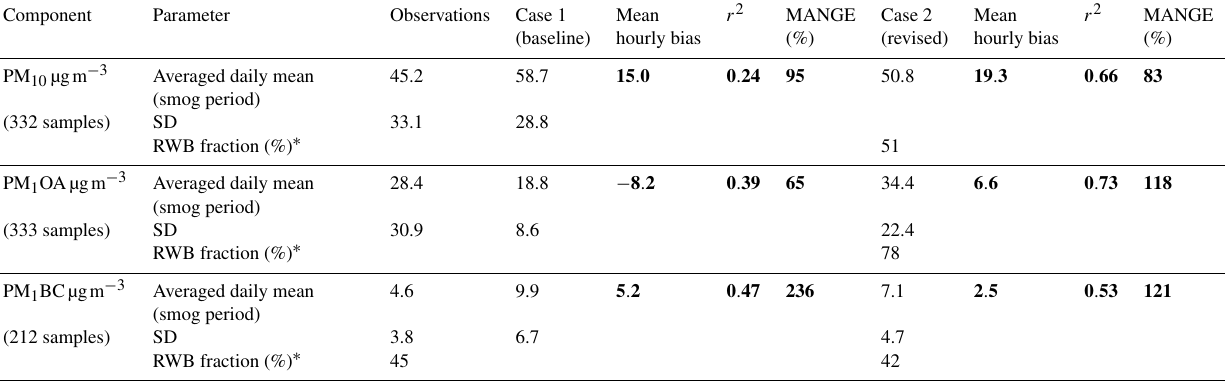
Table 3. Averaged daily mean values and prediction skill metrics of the aerosol concentrations (and RWB mass fractions) against ground measurements (at Thissio) during the RWB smog period (19 December 2013–5 January 2014) in Athens. Numbers in bold represent the calculated statistics, given by Eqs. (A1) and (A2). SD is the standard deviation.